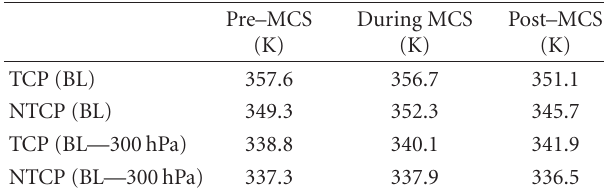
Table 5: Mean θ e (using Bolton [56]) for within the boundary layer (BL) and for above the boundary layer (BL—300hPa). Mean θ e are provided for times prior to, during, and after MCS progression through the study